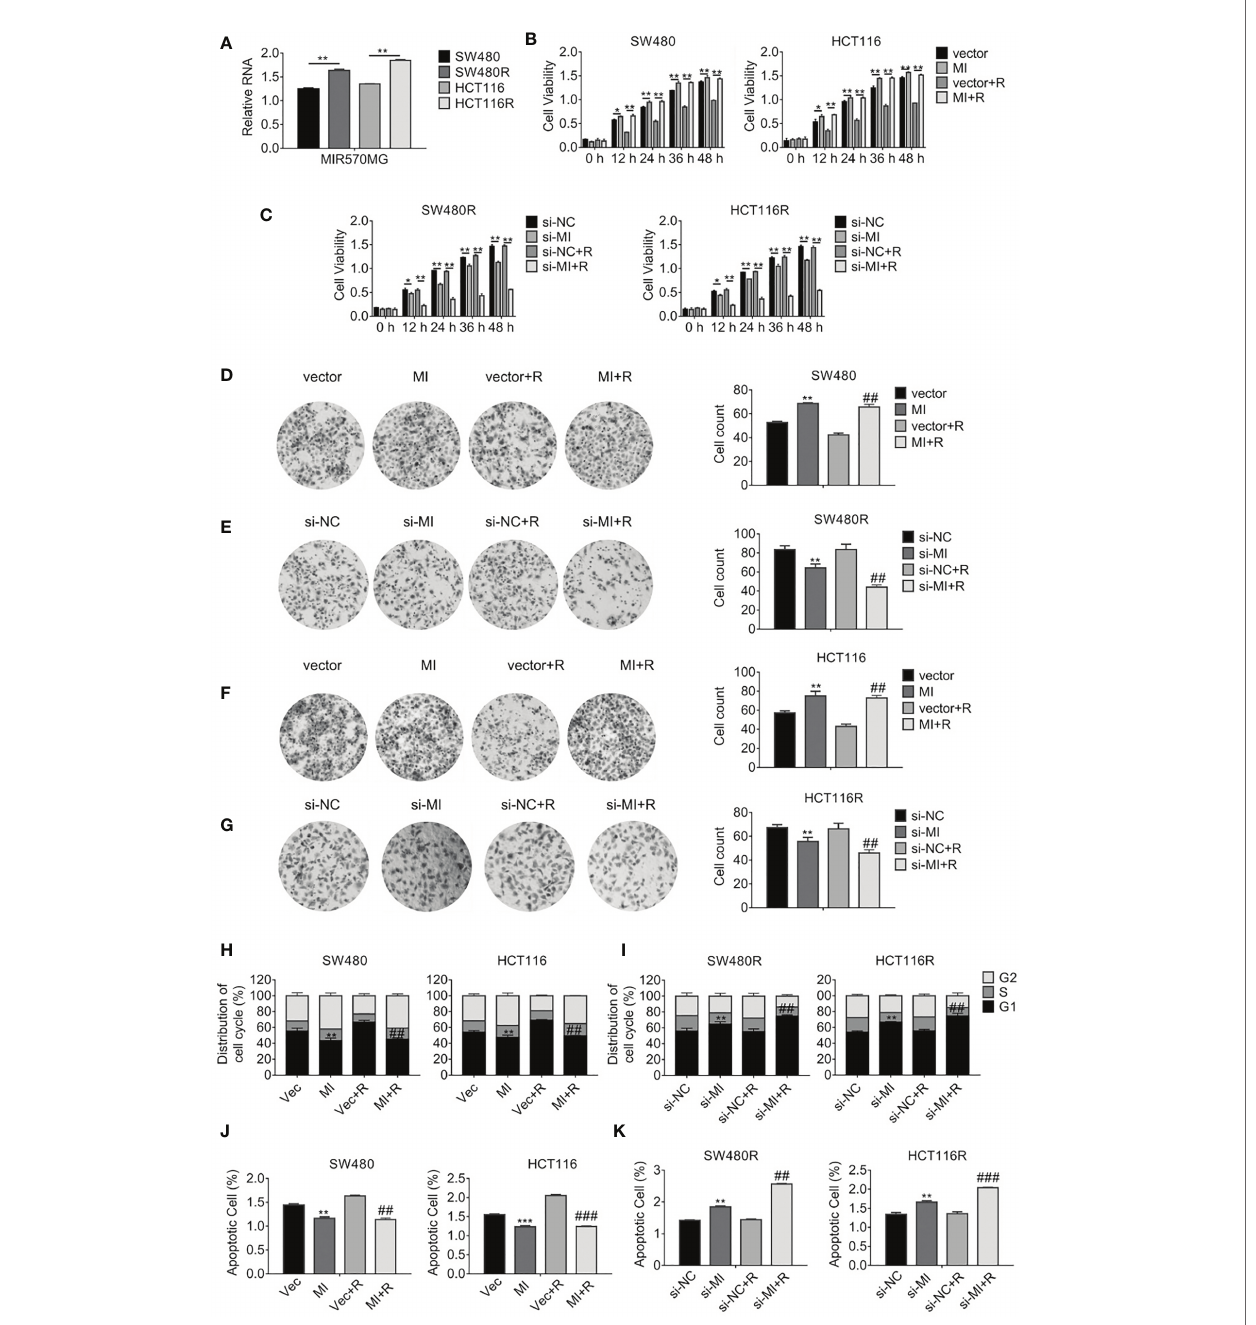
FIGURE 2 | LncRNA MIR570MG expression increases and enhances the cell viability of regorafenib-resistant cell lines. (A) Expression of MIR570MG in regorafenib resistant- and parental cells. (B) The viability of the indicated cells was accessed by the MTT assay. Cells expressing MIR570MG or vector were exposed to regorafenib. MTT assay was performed at the indicated time-points. (C) The viability of the indicated cells was accessed by the MTT assay. Cells expressing si- MIR570MG or si-NC were exposed to regorafenib before MTT assay. (D – G) Clonogenicity of the indicated cells was measured by colony formation. Cells were transfected with MIR570MG or si-MIR570MG for 24 h prior to regorafenib treatment and colony formation assay was conducted. (H, I) The distribution of the cell cycle of the indicated cells was analyzed by fl ow cytometry. Cells are expressing MIR570MG or si-MIR570MG at the presence or absence of regorafenib. Twenty- four hours later, the fl ow cytometry analysis was carried out. (J, K) The apoptosis of the indicated cells was accessed by the JC-1 assay, followed by fl ow cytometry analysis. Cells expressing MIR570MG or si-MIR570MG were exposed to regorafenib. Data represents mean ± SD of three individual experiments. *P < 0.05, **P < 0.01, ***P < 0.001, vs. vector or si-NC; ## P < 0.01, ### P < 0.001, vs. vector or si-NC plus regorafenib exposure. MI, MIR570MG; si-MI, si-MIR570MG; NC, negative control; R, Reg, 1 m M regorafenib